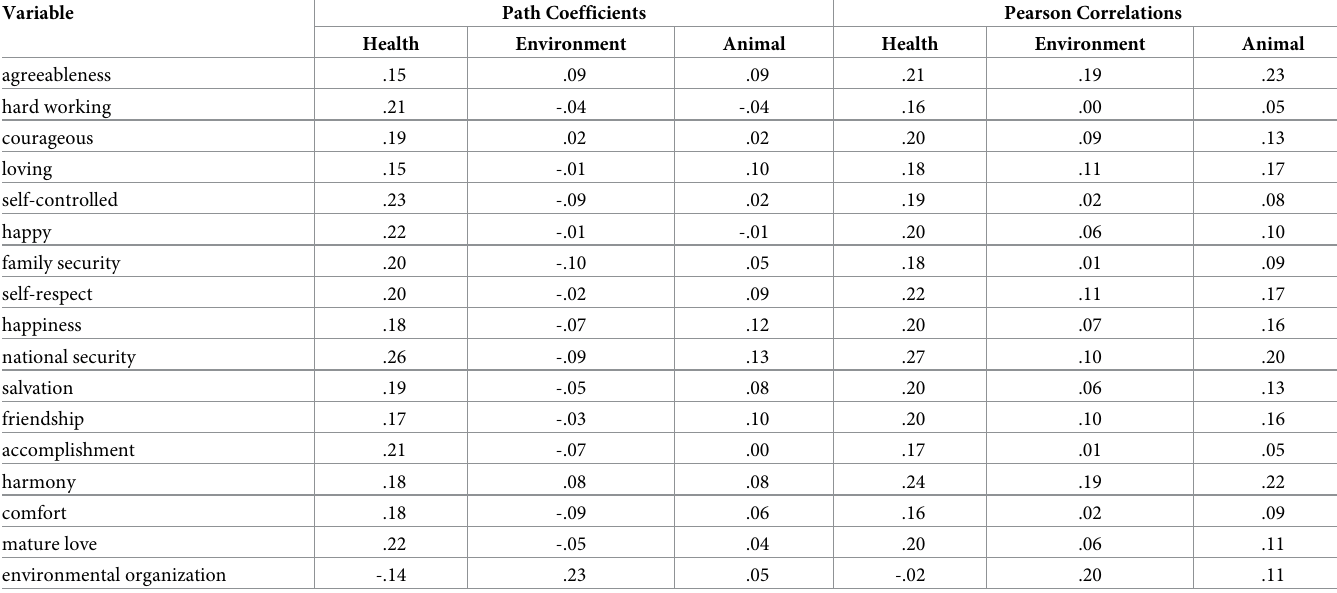
Table 7. Replicated associations in the LISS sample.